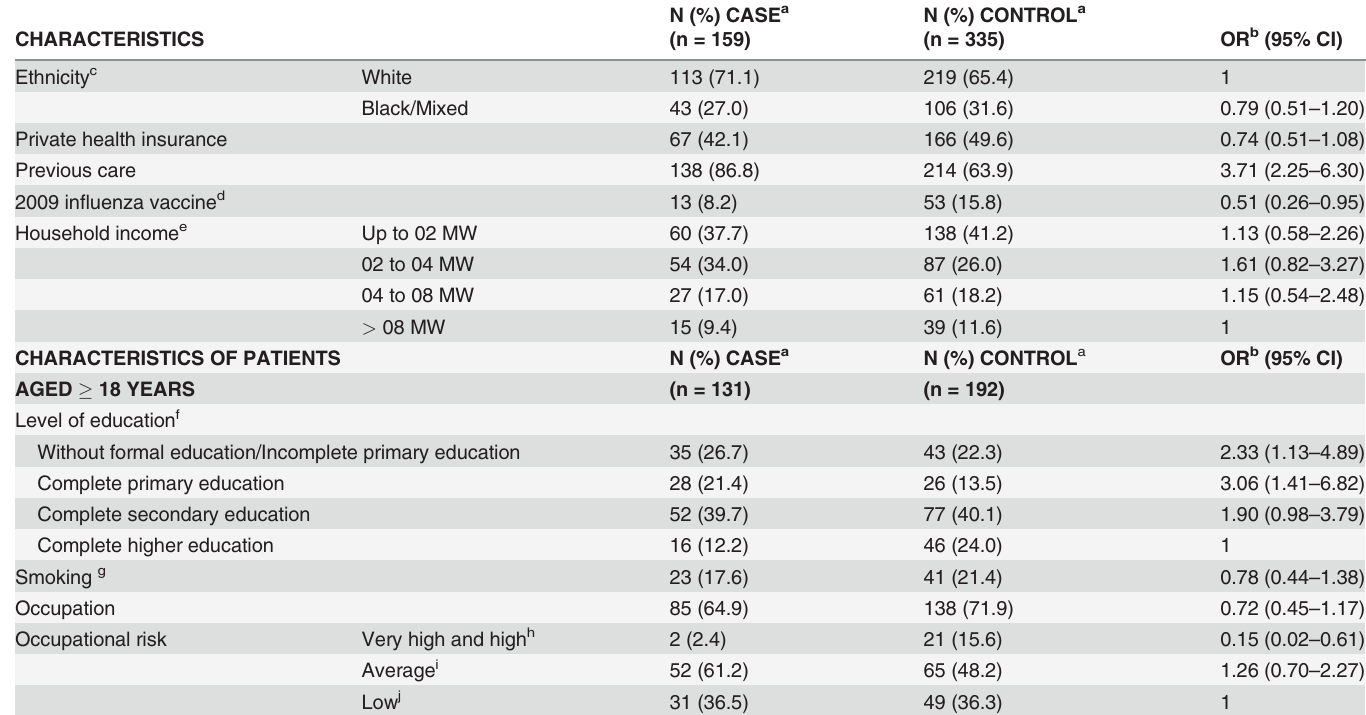
Table 1. General and socio-demographic characteristics of patients hospitalized due to in fl uenza A(H1N1)pdm09 associated with Severe Acute Respiratory Illness, who died (case) or recovered (control), metropolitan regions of S ã o Paulo and Campinas, state of S ã o Paulo, Brazil, 2009. N (%) CASE a N (%) CONTROL